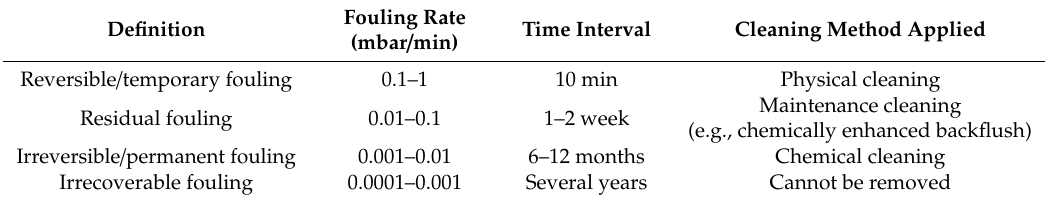
Table 4. Di ff erent fouling